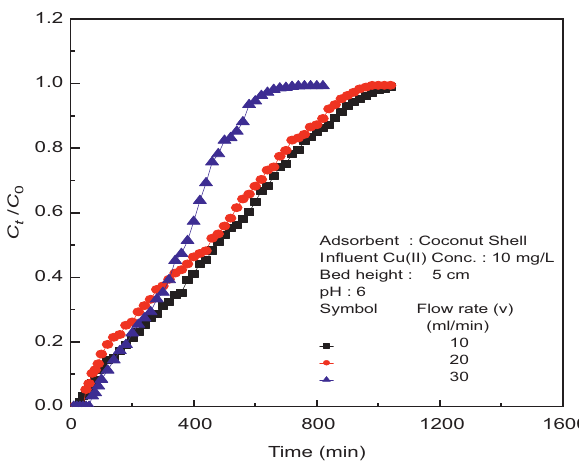
Figure 4. Effect of flow rate for Cu(II) adsorption on coconut shell at constant bed height and influent metal ion concentration